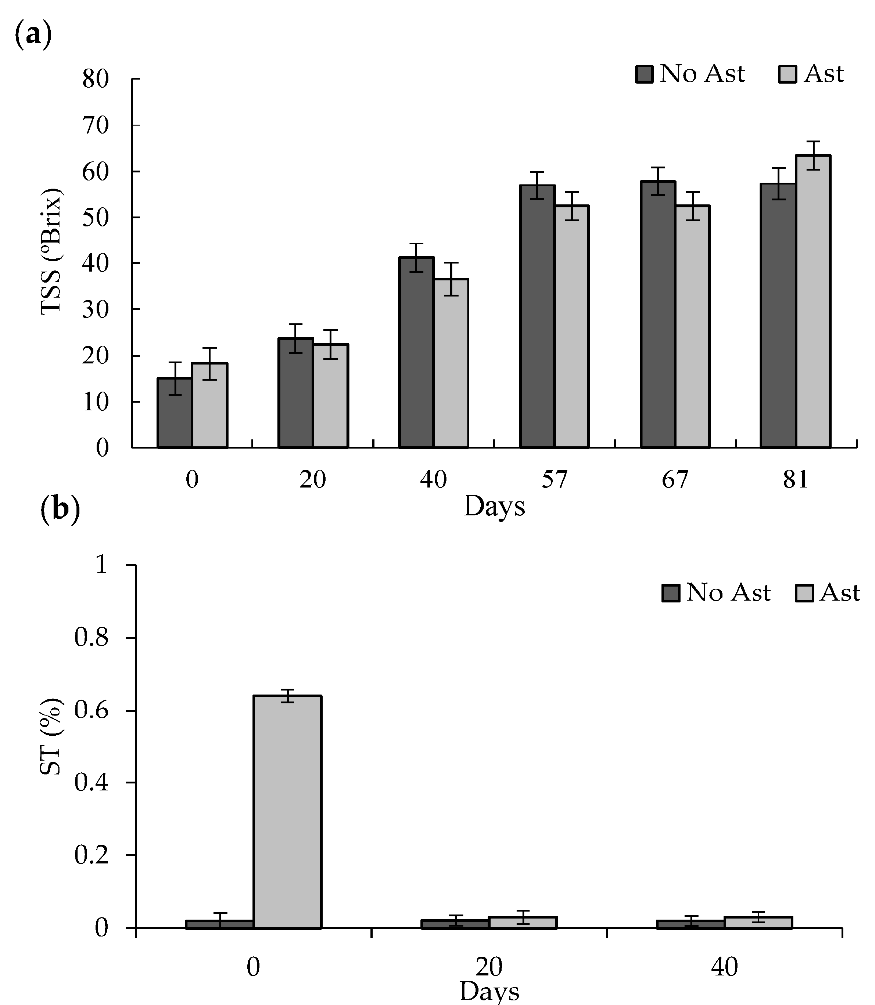
Figure 4. Total soluble solids (TSS) of the non-astringent (no Ast) and astringent (Ast) persimmon samples during the drying treatment ( a ). Total soluble tannin content (ST) of the non-astringent (no Ast) and astringent (Ast) persimmon samples up to the drying treatment at Day 40 ( b ). Bars represent the least significant difference (LSD) intervals ( p ≤ 0.05).